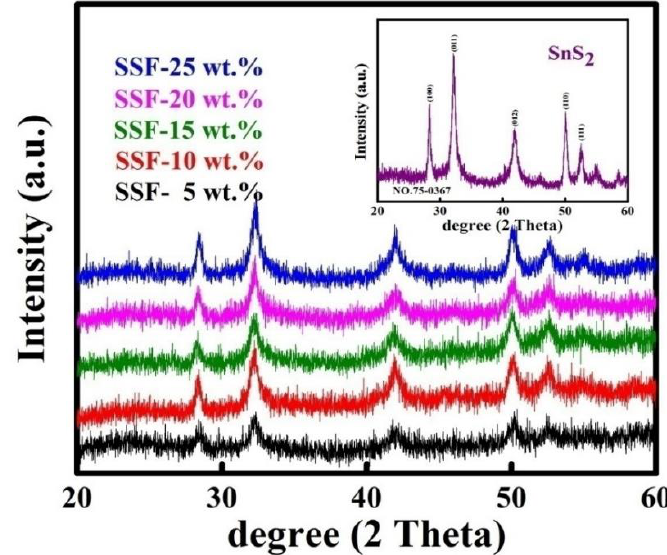
Figure 1. XRD patterns for SnS 2 -SiO 2 @ α -Fe 2 O 3 nanocomposites with different concentrations (SSF-5, 10, 15, 20, and 25 wt %). The inset shows the XRD pattern for as-synthesized flower-like SnS 2 .